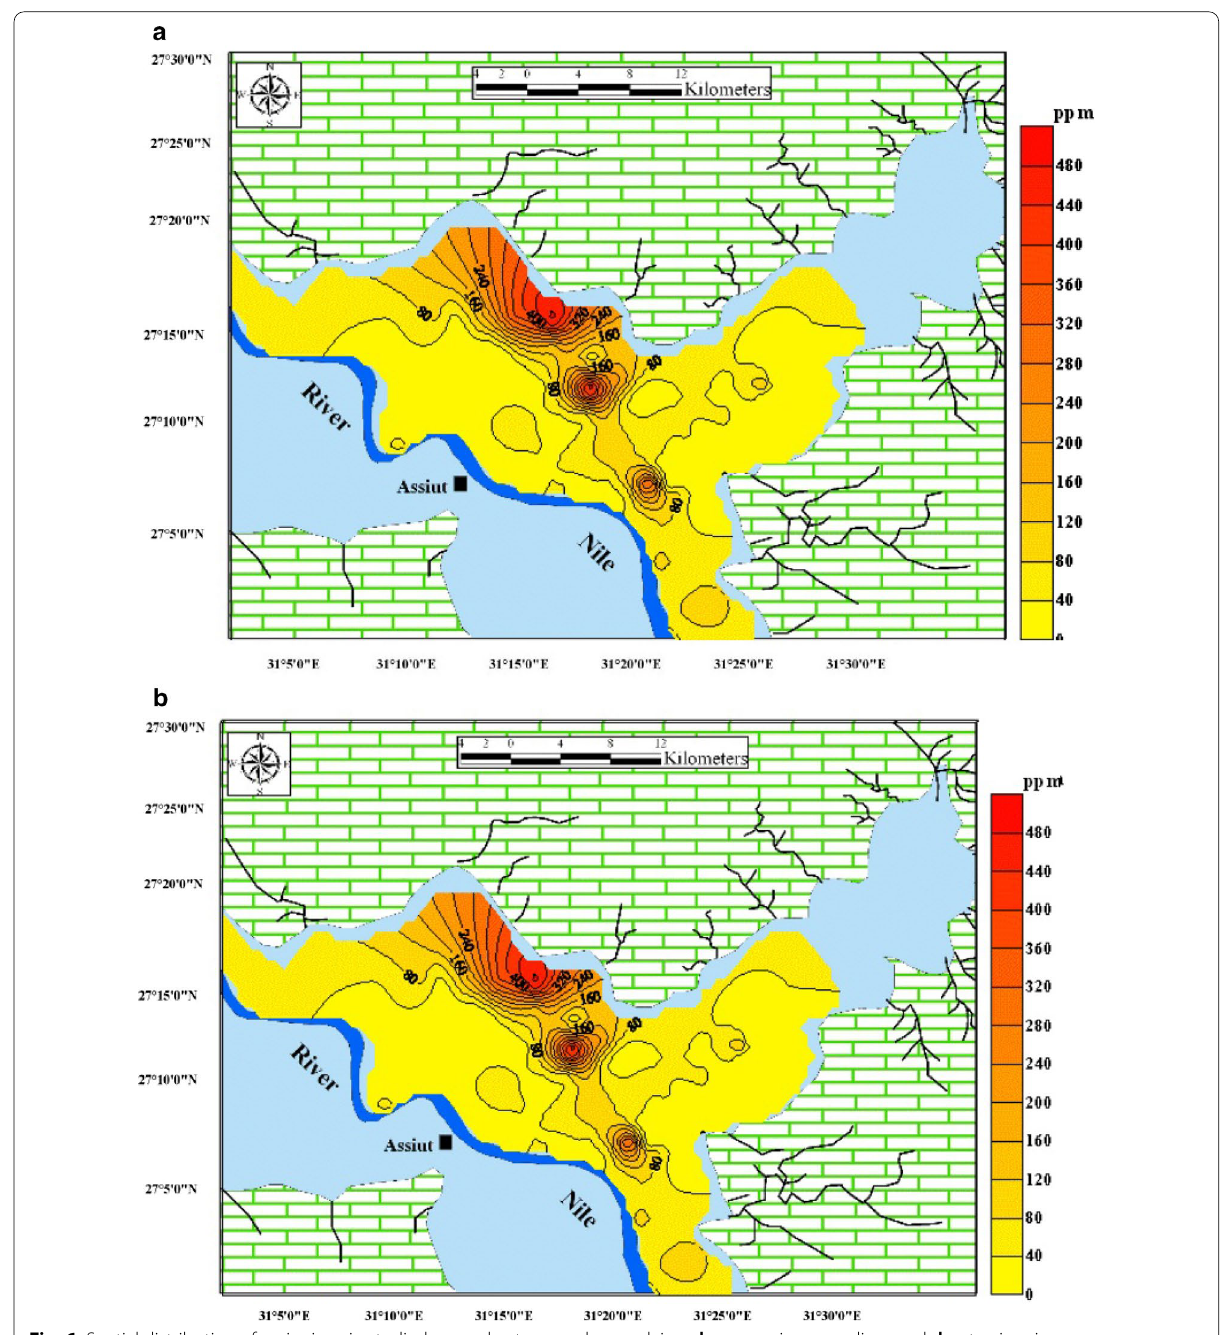
Fig. 6 Spatial distribution of major ions in studied groundwater samples: a calcium, b magnesium, c sodium and d potassium